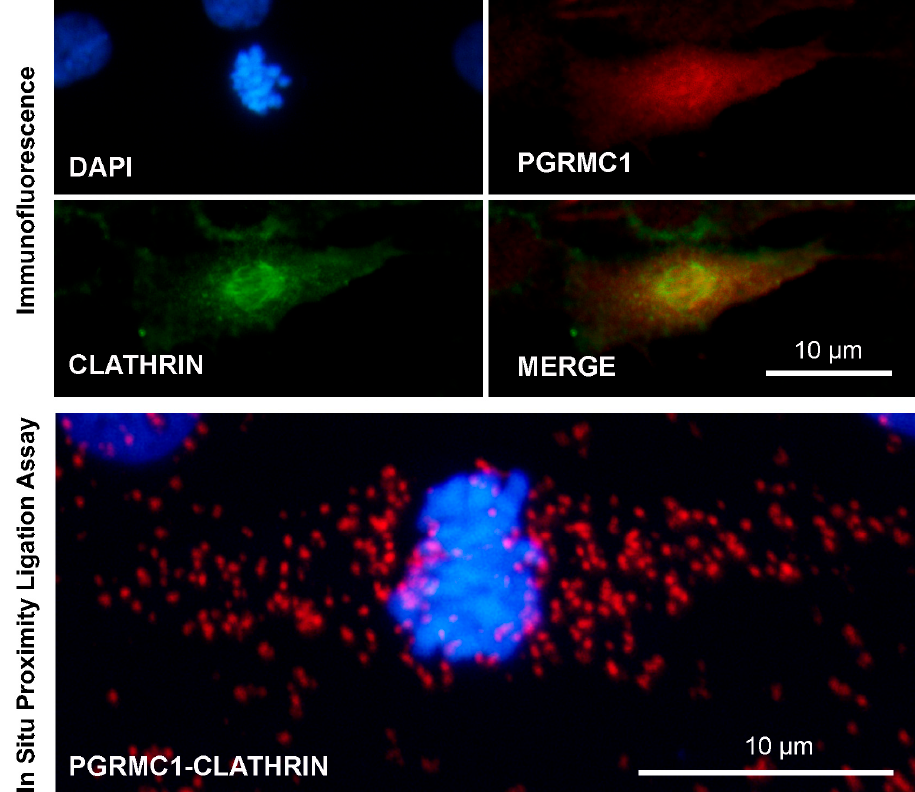
Figure 4. Images showing immunofluorescent and in situ proximity ligation assay to assess the association of PGRMC1 and clathrin in in vitro cultured bovine granulosa cells undergoing mitotic division. Analysis was conducted as described in [113,163] with proper combination of antibodies, which were rabbit anti-PGRMC1 (Sigma Aldric Prestige antibody HPA002877, 1:50) and mouse monoclonal anti-clathrin heavy-chain antibody (X22) (ThermoFisher Scientific, 1:500). Nuclei were counterstained with DAPI. Controls were performed by eliminating one of the two primary antibodies, as shown in Supplementary Figure S1. Data were presented at the 48th Annual Meeting of the Society for the Study of Reproduction, 18–22 June 2015, San Juan, Puerto Rico,